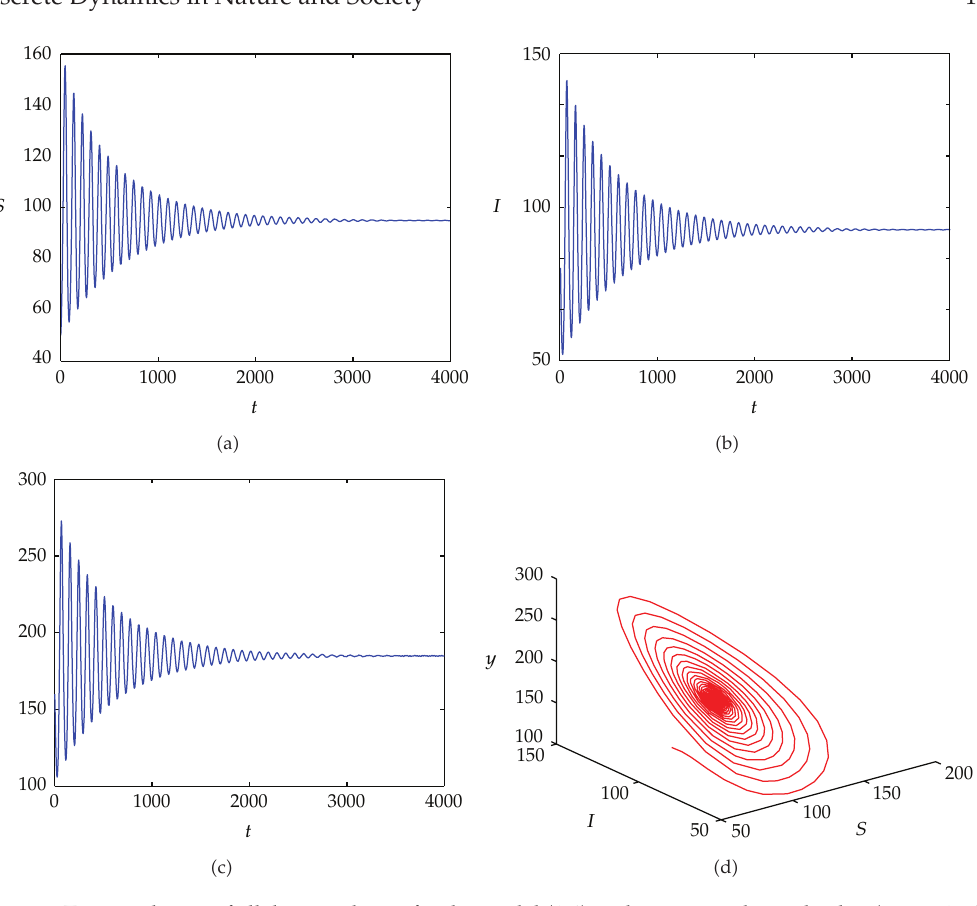
Figure 2: Time evolution of all the population for the model (cid:4) 1.4 (cid:5) with τ (cid:8) 3 . 3 and initial value (cid:4) 50 , 80 , 160 (cid:5) . (cid:4) a (cid:5) , (cid:4) b (cid:5) and (cid:4) c (cid:5) are S , I and y versus t , respectively, and (cid:4) d (cid:5) is the projected S - I - y phase